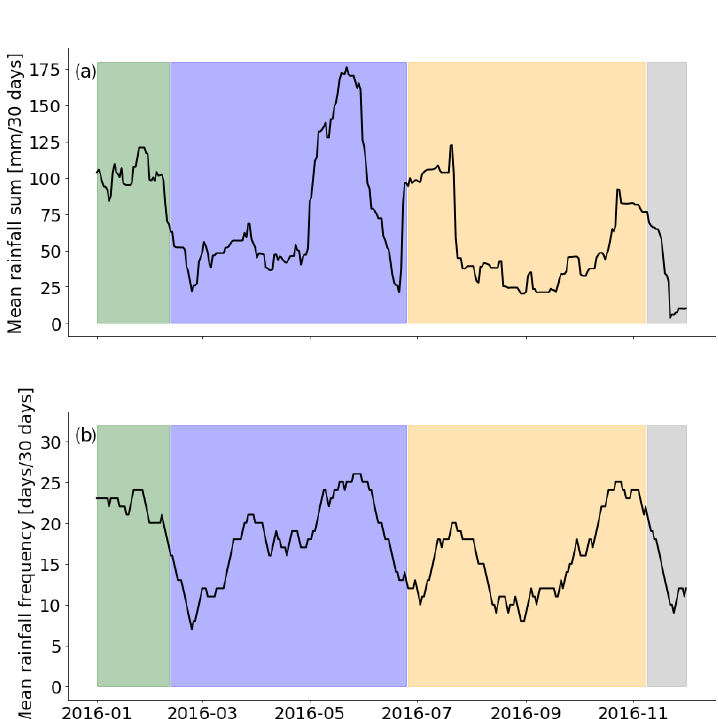
Figure B1. Mean rolling rainfall sum (a) and rainfall frequency (b) for 2016. The colored boxes indicate the current cluster as shown in Fig. 3d. Both values were calculated for the same windows as the dispersion functions by using Eq. (1) for the daily rainfall sums, with the total rainfall sum in the window in (a) and the number of days of rainfall occurring in (b)